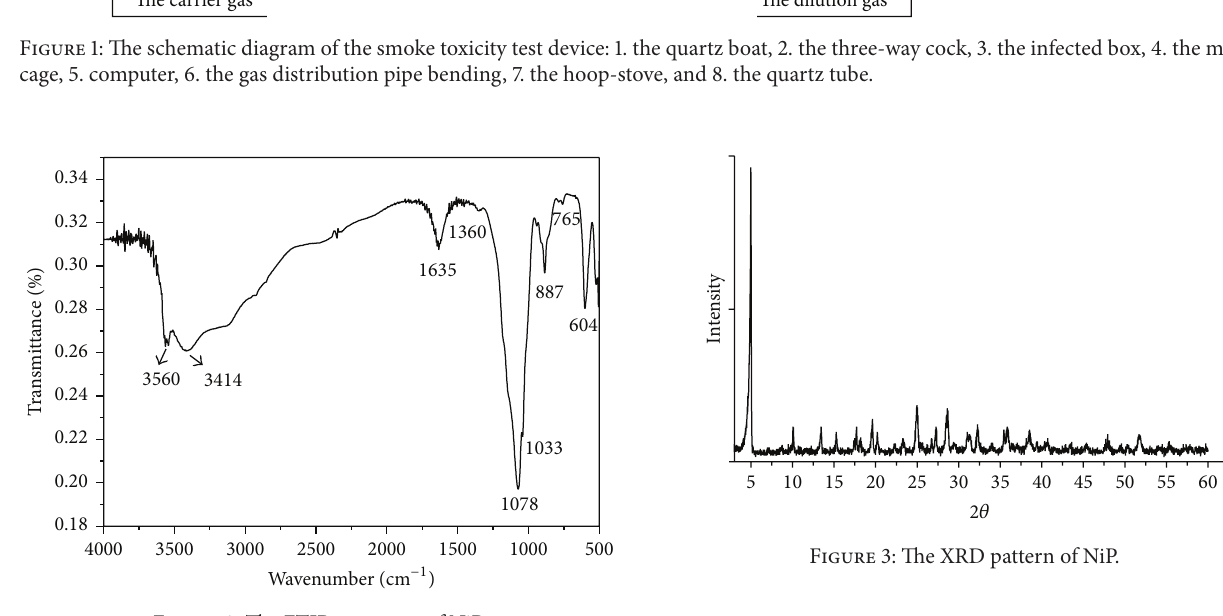
Figure 2: The FTIR spectrum of NiP.